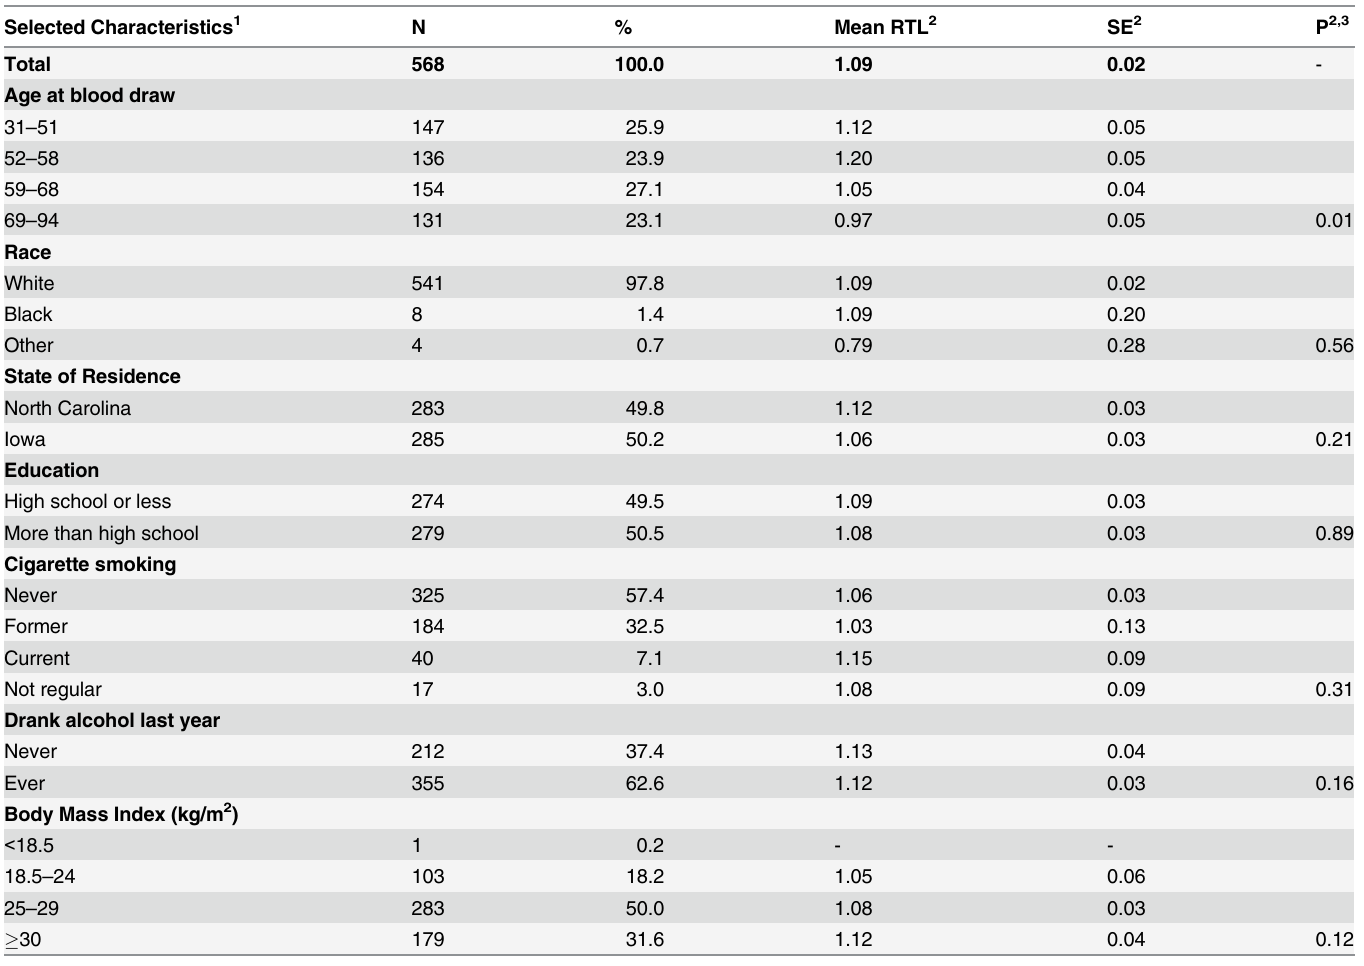
Table 1. Mean relative telomere length by selected